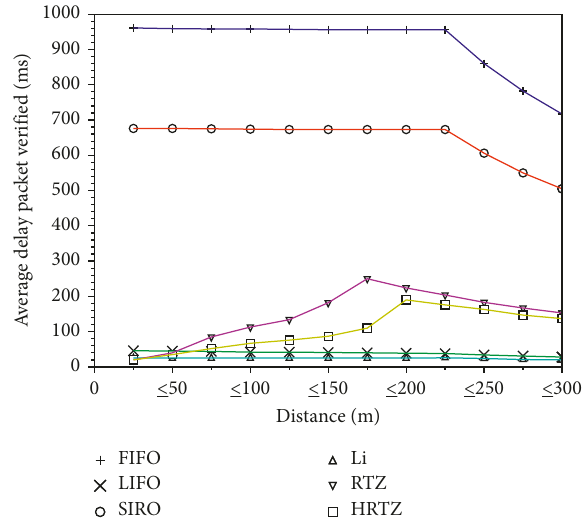
Figure 11: Average delay of verified messages versus distances between vehicles.